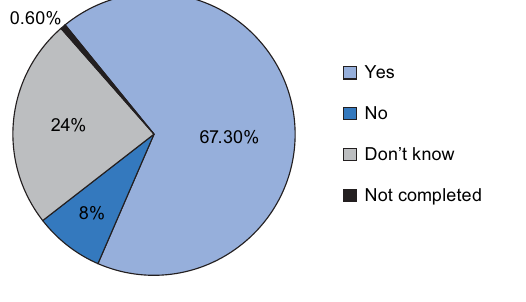
Figure 6: Perception of exercise in controlling DM.